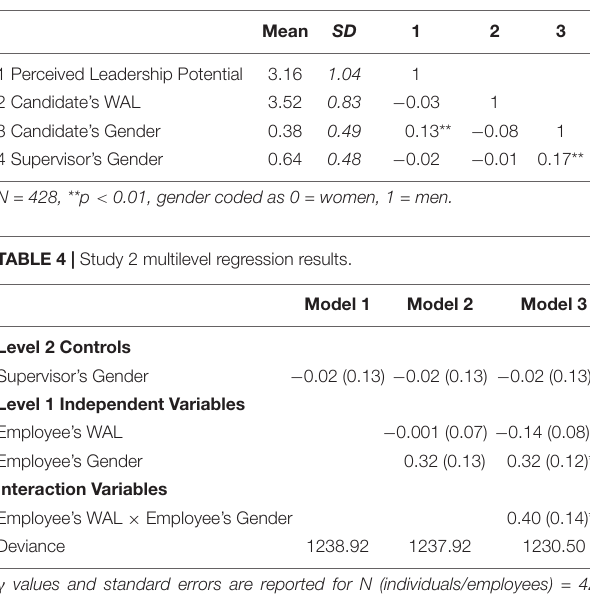
TABLE 3 | Study 2 descriptive statistics and correlations.